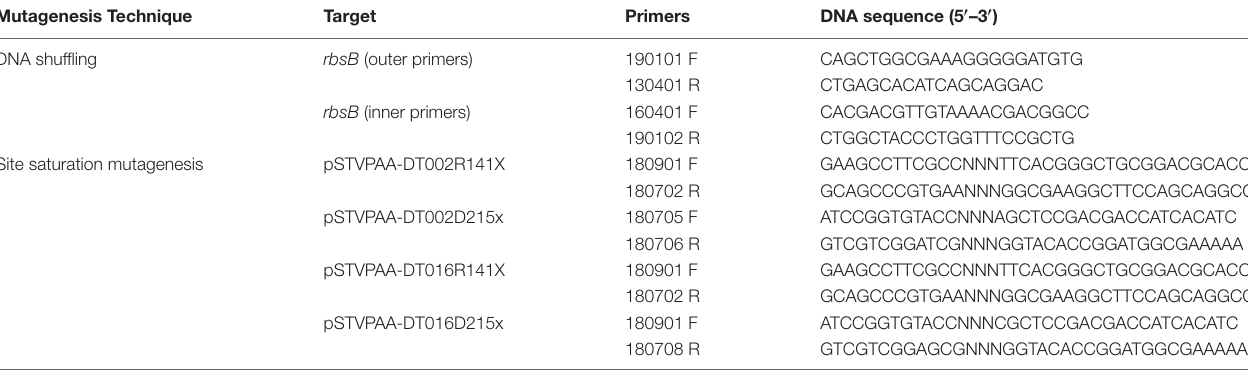
TABLE 4 | List of primers used to introduce new mutations in RbsB-derivate proteins.